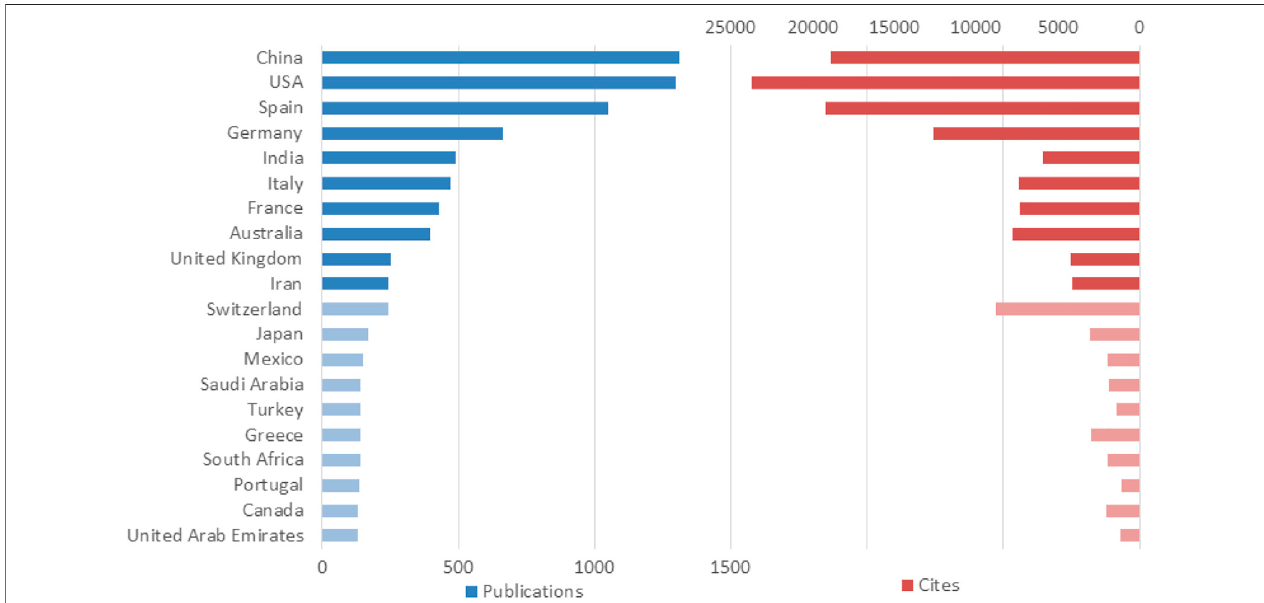
FIGURE 3 | Top 20 publishing countries in the CSP fi eld by number of publications and cites.